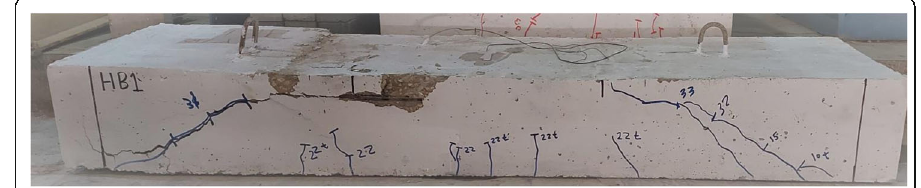
Fig. 7 Crack patterns at failure for shallow wide tested beam